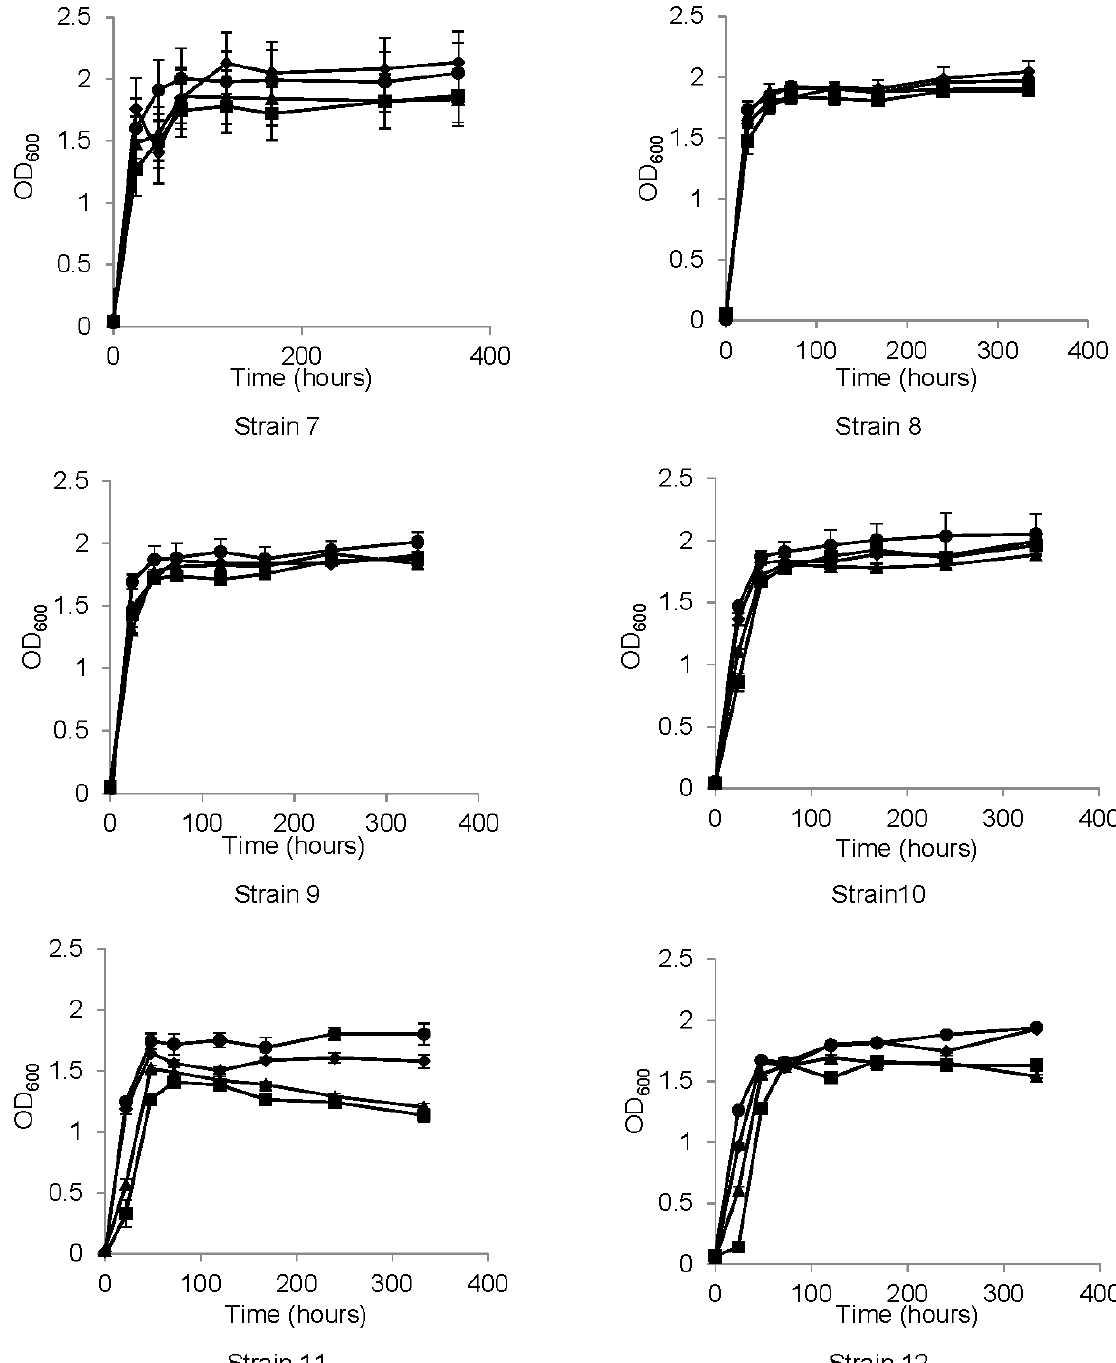
Figure 1. Growth curves for each strain in the presence or absence of added hydroxycinnamic acid (HCA). MYPG culture medium was supplemented with 4 mM HCA and growth measured by optical density at the indicated time points. Circles, control (no HCA); squares, ferulic acid; triangles, p -coumaric acid; diamonds, caffeic acid. Bars represent standard error of the